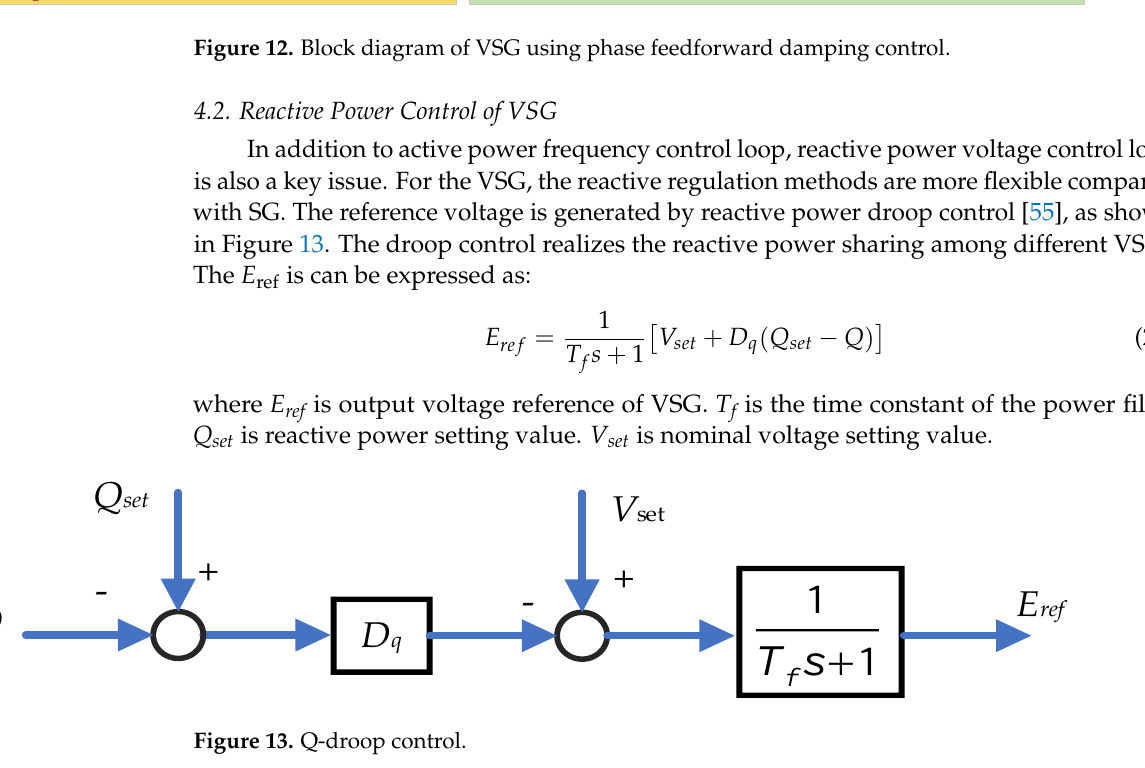
Figure 12. Block diagram of VSG using phase feedforward damping control.